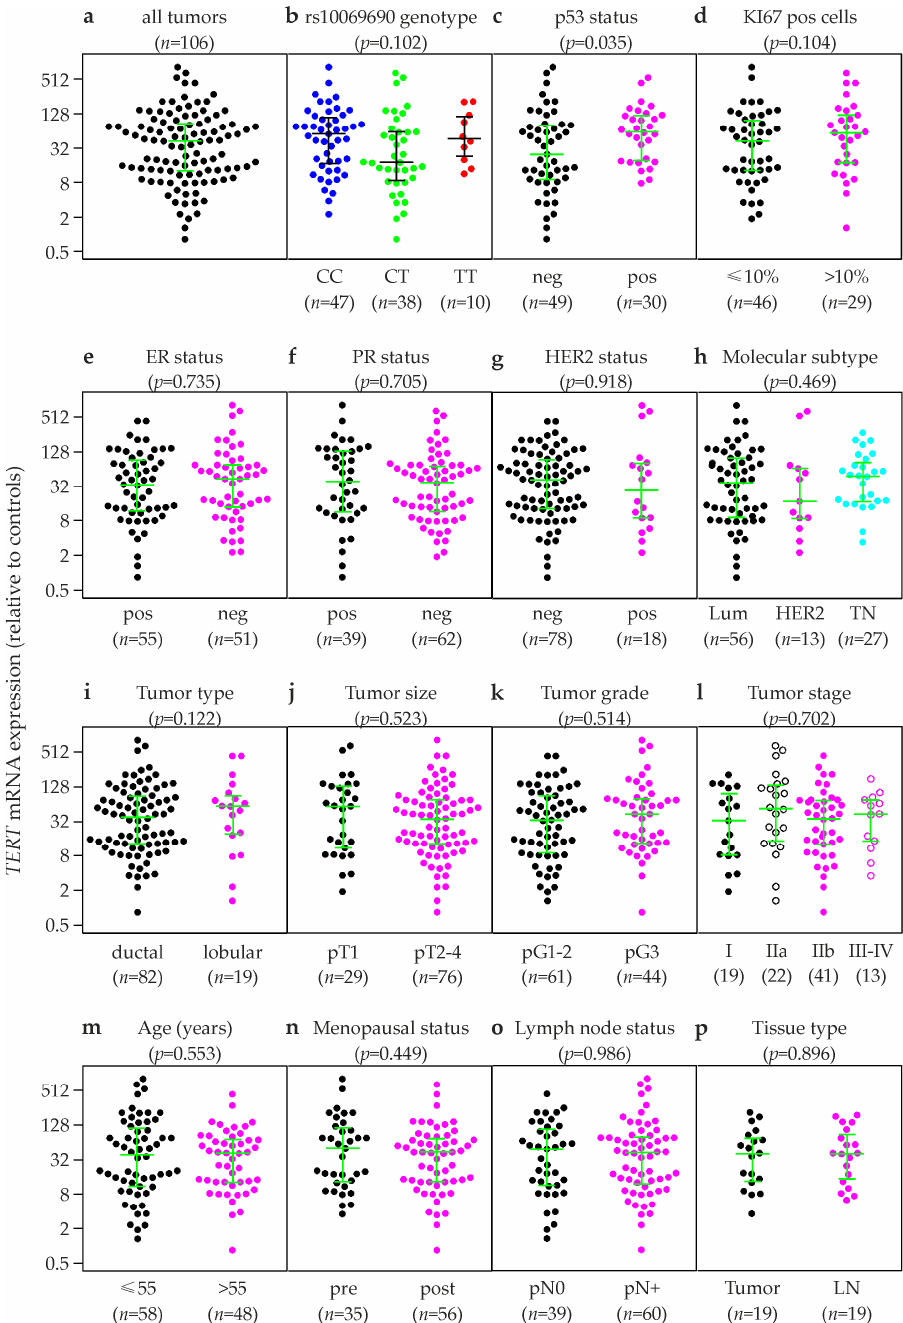
Figure 2. Association of TERT mRNA expression with established clinical and histopathological parameters. Strip charts of TERT expression of all tumors ( a ), and according to rs10069690 genotype ( b ), p53 status ( c ), KI67 status ( d ; ≤ 10% vs. >10% KI67 pos cells), estrogen receptor (ER) status ( e ), progesterone receptor (PR) status ( f ), HER2-status ( g ), molecular subtype [ h ; luminal A and B (Lum), HER2-type (HER2), and triple-negative (TN)], tumor type ( i ), size ( j ), grade ( k ) and stage ( l ); age at breast cancer onset ( m ), menopausal status ( n ), lymph node status ( o ), and in paired primary tumors and lymph node metastases (LN; p ). neg, negative; pos, positive. The numbers of patients in each group ( n ) are shown in parentheses. The y-axes show normalized relative TERT mRNA levels (linear values). Horizontal lines in panels indicate the first, second (i.e., median), and third quartiles. P -values ( p , in parentheses above each panel) were determined by Kruskal-Wallis tests.